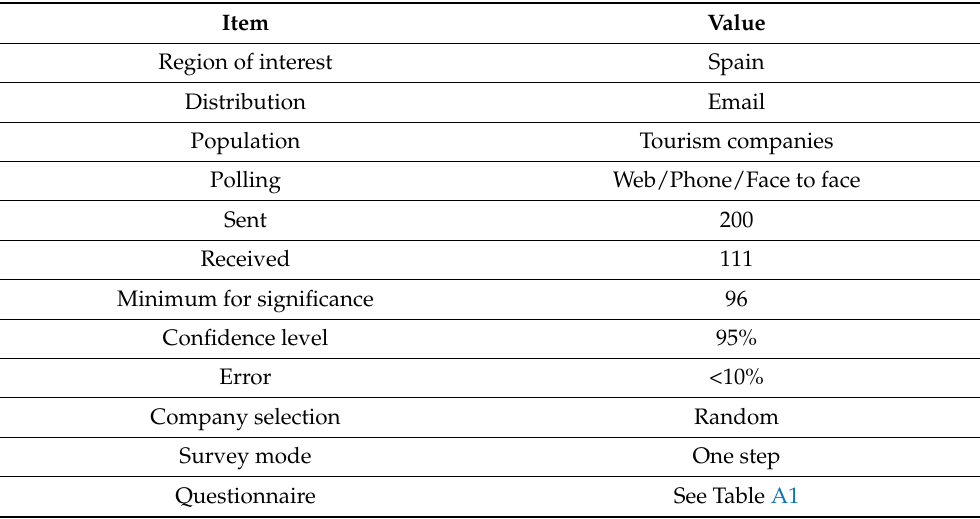
Table 1 details the technical aspects of the survey. Table 1. Technical description of the